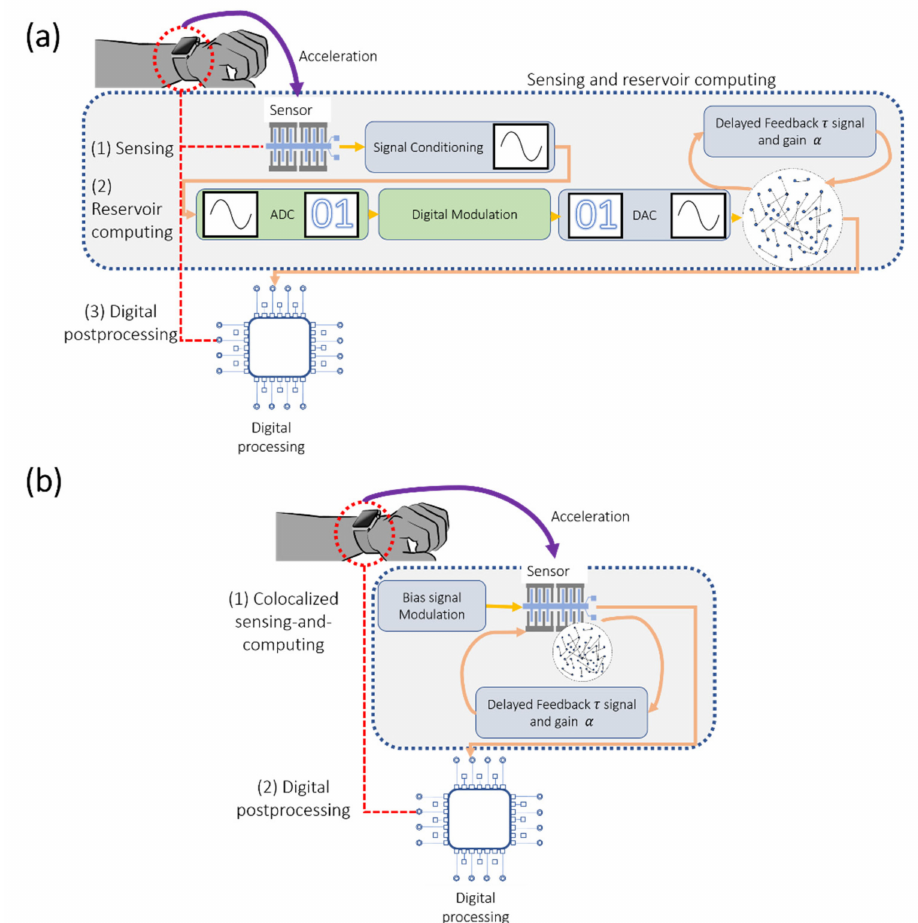
Figure 7. Illustration demonstrating the size reduction of the RC scheme with the use of sensors for colocalized sensing-and-computing. In this figure, digital components are represented by green blocks. Analog components are represented by grey components. ( a ) Delay RC scheme with separated sensing and computing. ( b ) Delay RC scheme with colocalized sensing and